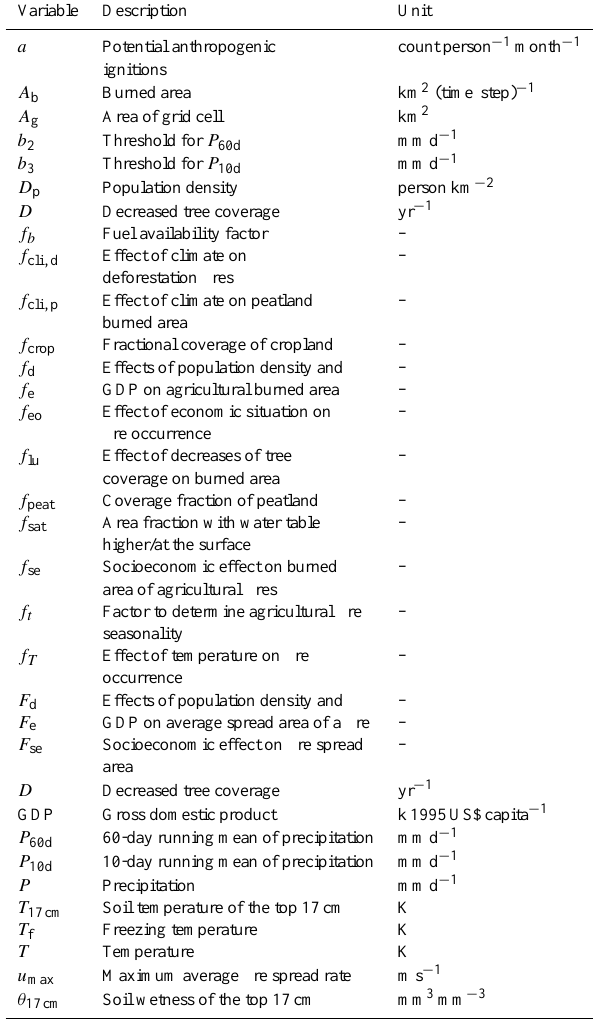
Table A1. List of model